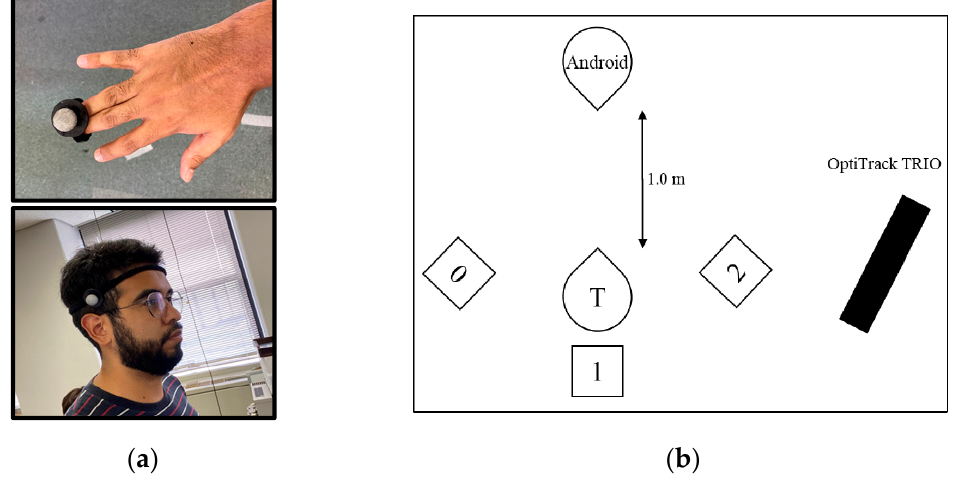
Figure 5. Implementation setup: ( a ) markers’ positions on the participant: hand for computing distance and head as reference for android’s reaction; ( b ) implementation setup using an OptiTrack system and three approaching angles: front, left, and right.